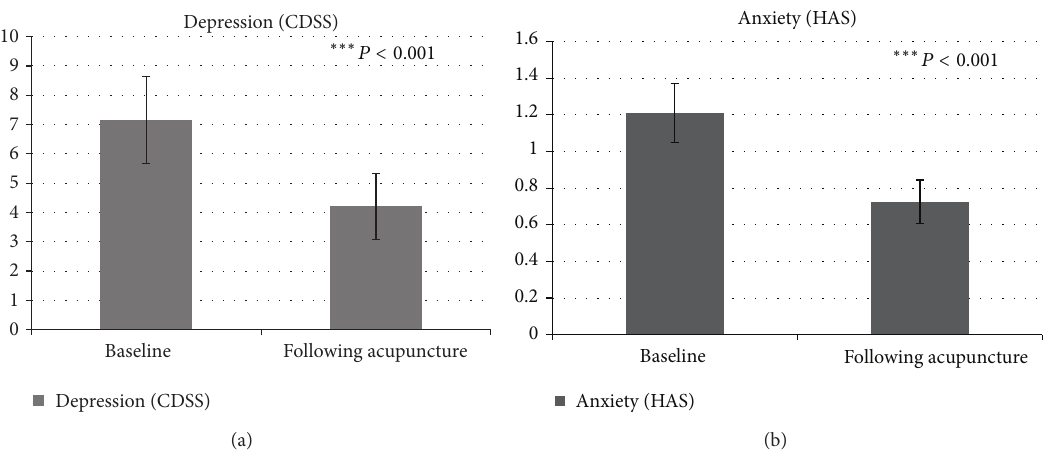
Figure 3: Emotional measures before and after acupuncture treatment: (a) depression level as measured by the Calgary Depression Scale for schizophrenia (CDSS), (b) anxiety level as measured by the Hamilton Anxiety Rating Scale